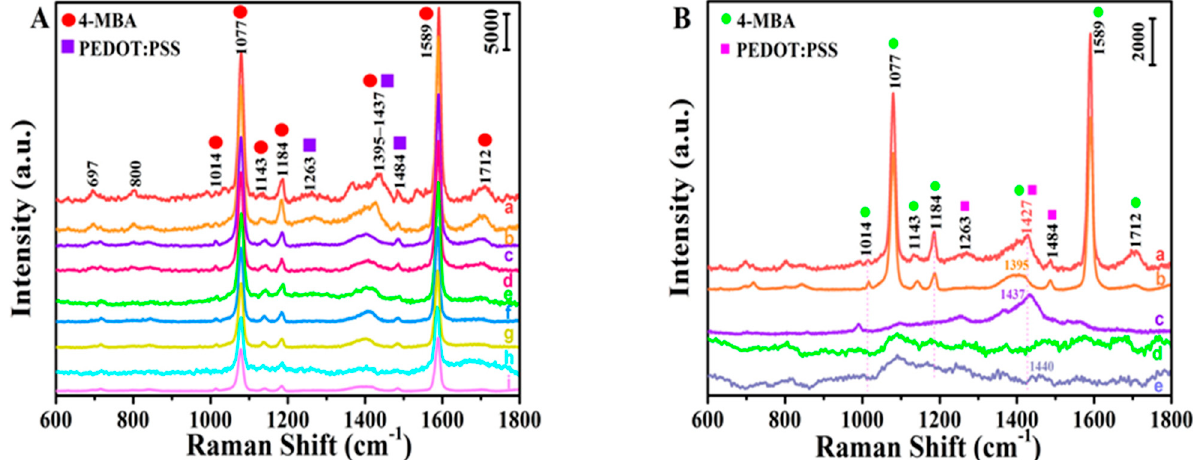
Figure 5. ( A ) SERS spectra of the Ag/4-MBA/PEDOT:PSS composite system with different concentrations of PEDOT:PSS (a–i: 1.0%, 0.8%, 0.5%, 0.3%, 0.2%, 0.1%, 0.075%, 0.05%, and 0%). ( B ) SERS spectra of (a) Ag/4-MBA/0.8% PEDOT:PSS, (b) Ag/4-MBA, (c) Ag/0.8% PEDOT:PSS, (d) 4-MBA/0.8% PEDOT:PSS, and (e) 0.8%